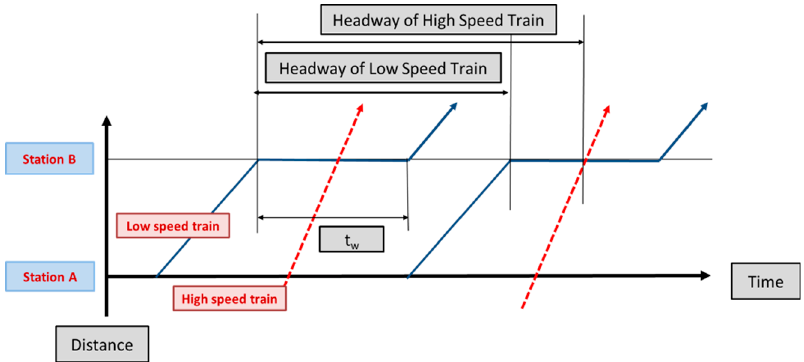
Figure 1. Scheduled waiting time for the operation of heterogeneous trains [26].